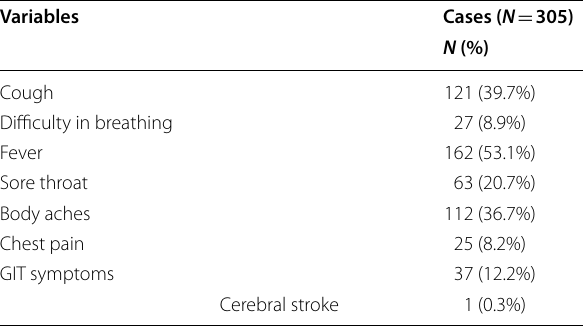
Table 2 Clinical presentation of the studied